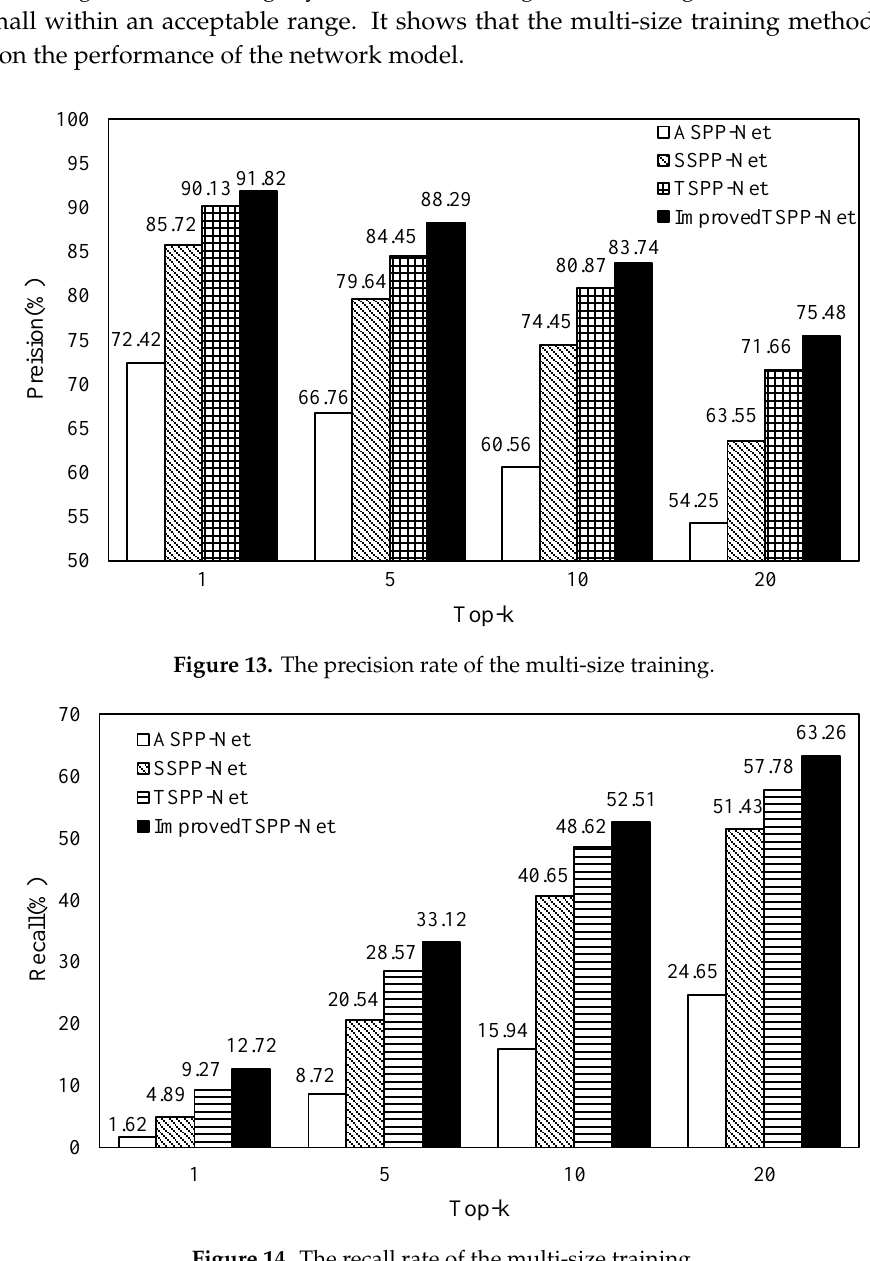
Table 1. Mean average precision.